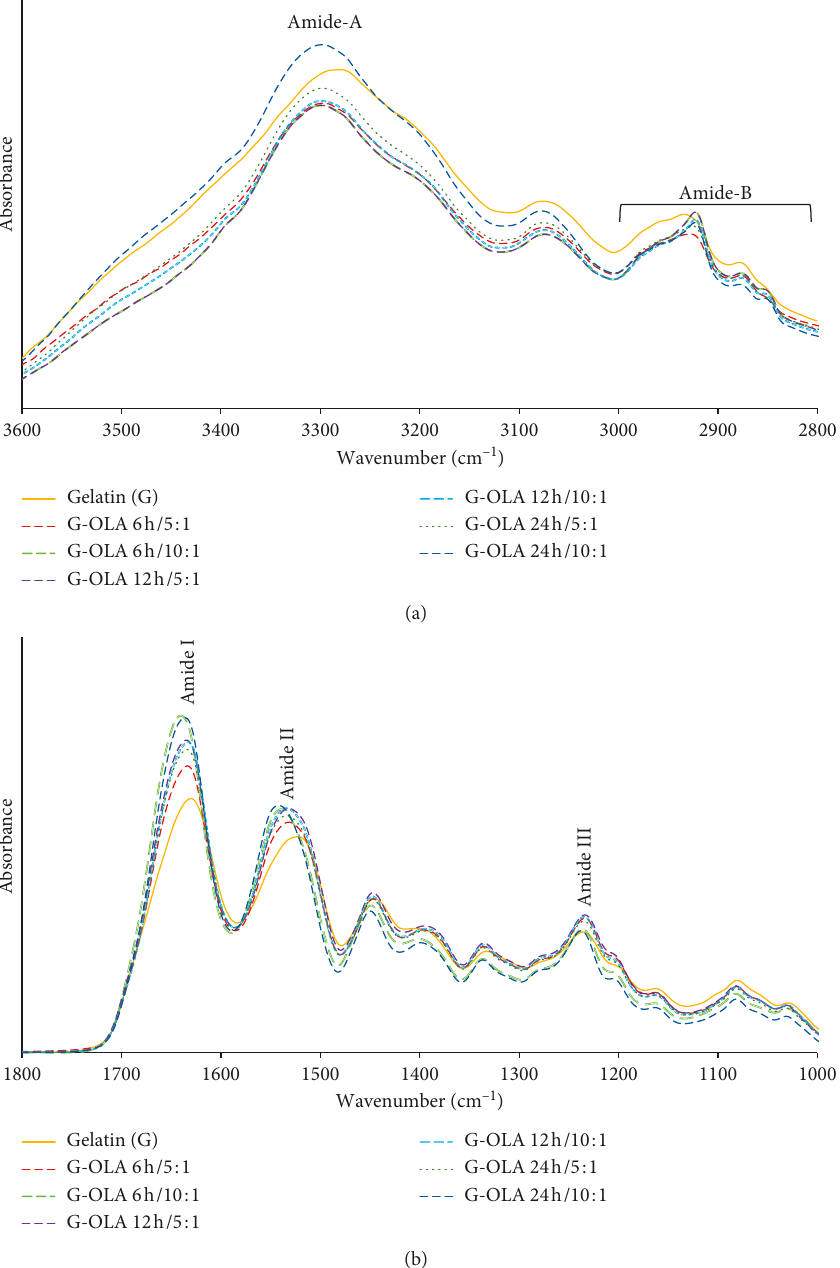
Gelatin. Protein patterns of fish skin gelatin modified with OLA having different oxidation rates and various OLA/NH group molar ratios in comparison with gelatin are shown in Figure 4. All modified gelatin samples showed similar pat- tern to the control gelatin (without OLA modification). All samples had α - and α -chains as the main components. α 1 2